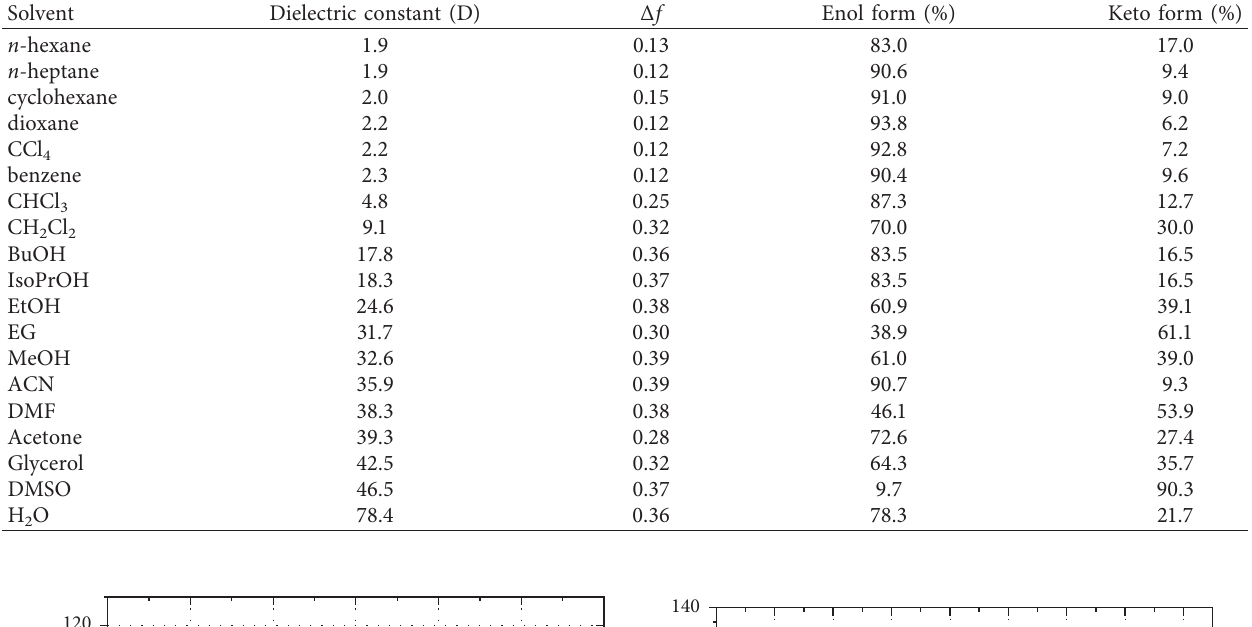
Table 5: The ketol/enol ratios when coumarin 3 was dissolved in solvents with different polarities and dielectric constants ( ε ).